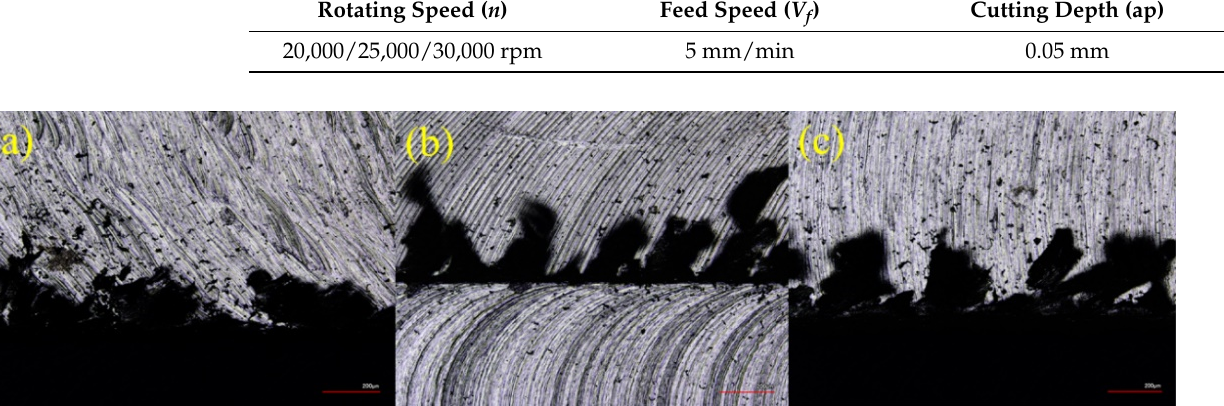
Figure 4. Surface roughness of different processing parameters.